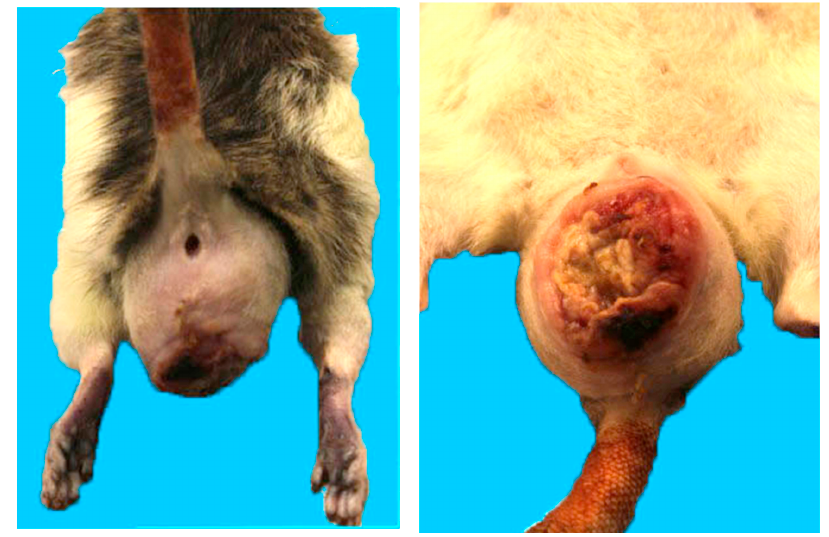
Figure 4. Dorsal view of a perineal mass in a mature female pet rat ( left ); Ventral view of ulcerated perineal mass in the same rat ( right ).